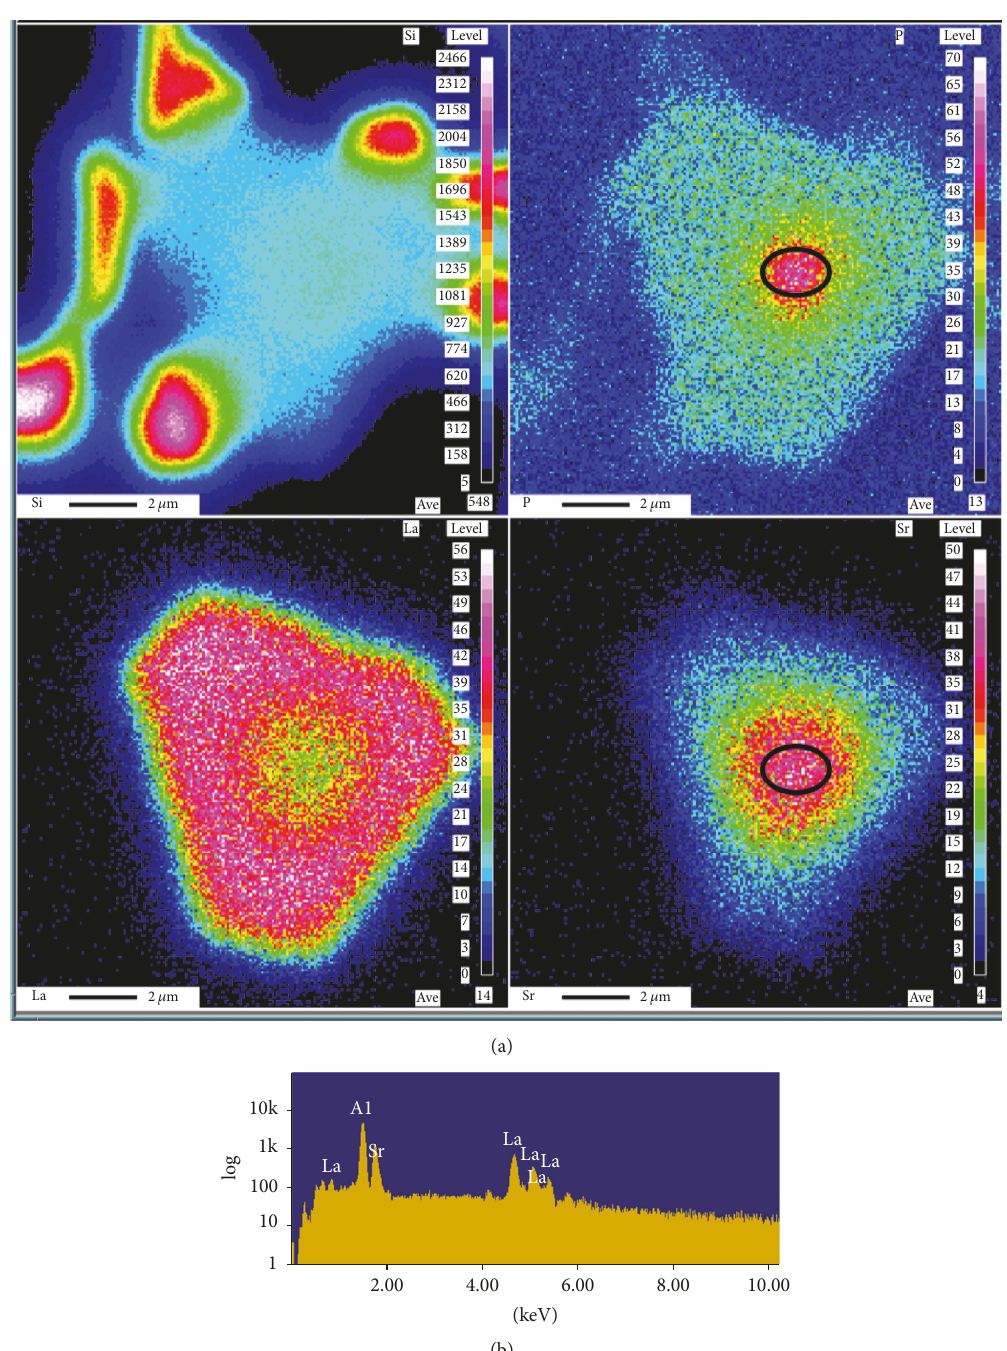
Figure 11: (a) Elemental distribution of Si, La, Sr, and P corresponding to a backscattered electron image showing La-rich platelet and surrounding Si particles in 100 ppm Sr-modified A356 alloy containing 1.025% wt.% La; (b) EDS spectrum of the La-rich platelet. Note the presence of P at the center of the Sr (circled